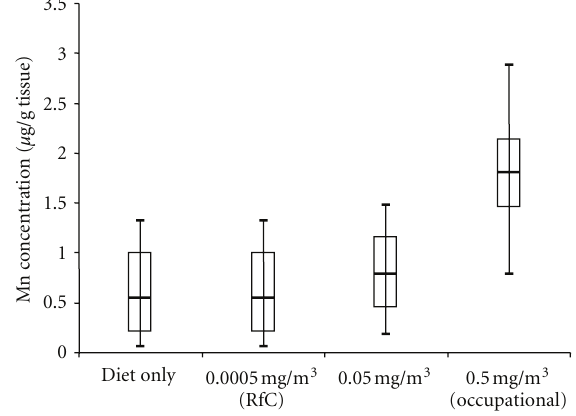
Figure 6: Distributions (min, 5th, med, 95th and max) of globus pallidus concentrations simulated for a human population with the input distributions described in Scenario 3 (see text for more details). Comparison of steady-state brain manganese concentra- tion following 365 days of continuous exposure (24hr/7